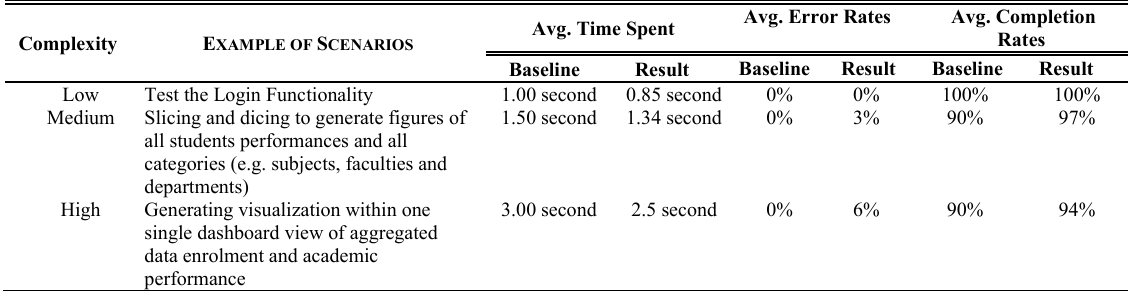
TABLE 4 R ESULTS OF USABILITY